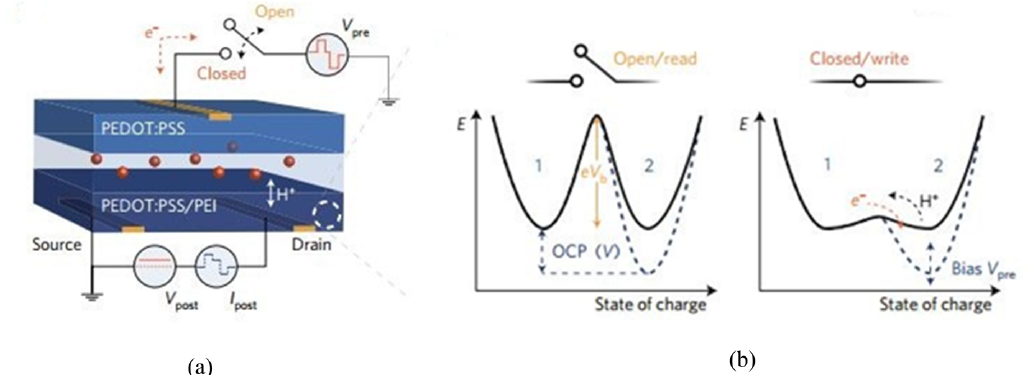
Figure 15: (a) Schematic of ENODe device. (b) Schematic explaining the decoupling of the read and write operations. Non-volatile redox cell ensures a very high eV b barrier between the two oxidation states of PEDOT ‘1’ and ‘2’ (corresponding to two conductance states of the postsynaptic electrode) during an open read operation and a very low barrier during a closed write operation. The open circuit potential (OCP), depicted in dashed lines, is dependent on the oxidation state of PEDOT and can be overcome by the bias. (Reprinted with permission from Y. Van de Burgt, E. Lubberman, E.J. Fuller et al.// Nat. Mater. 16(2017) 414 (C) 2017 Nature publishing